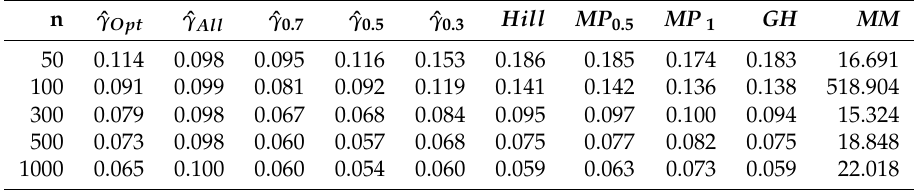
Table 3. RMSE of the estimators for the Fréchet(1.5) distribution; 1000 Montecarlo replications.